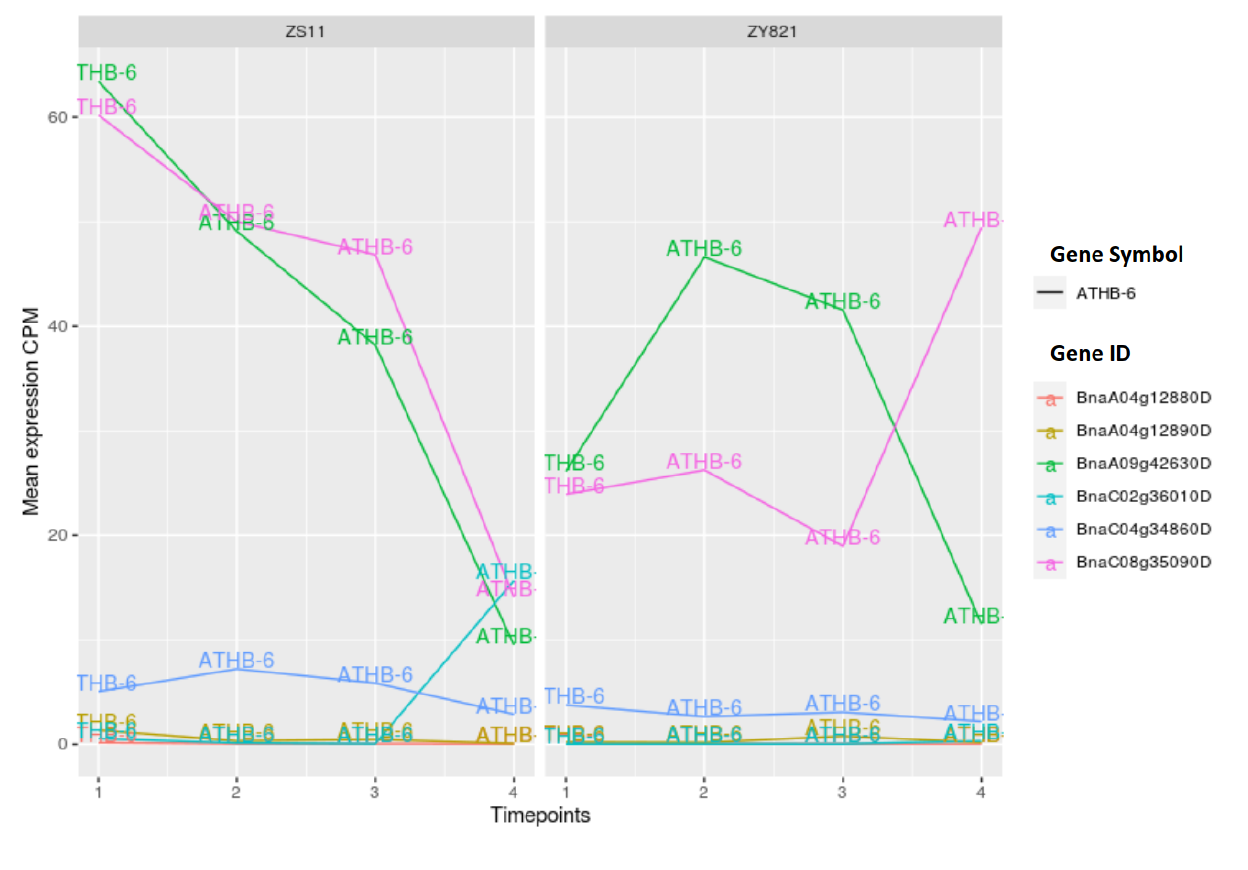
Figure 8. Expression values of ATHB-6 orthologous genes. Time points 1 to 4 represents day 7, day 10, day 15, and day 45 after